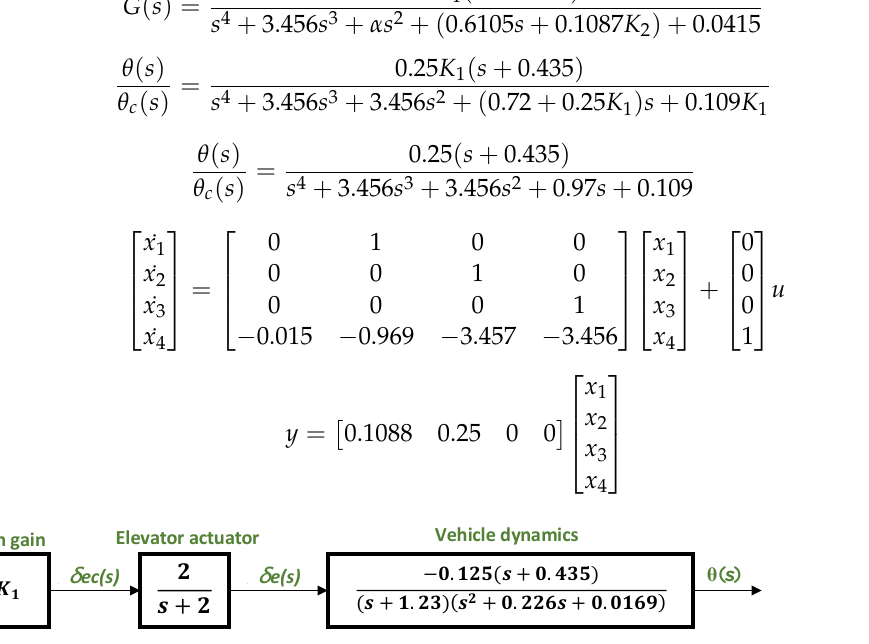
Figure 2. Open loop block diagram of pitch control